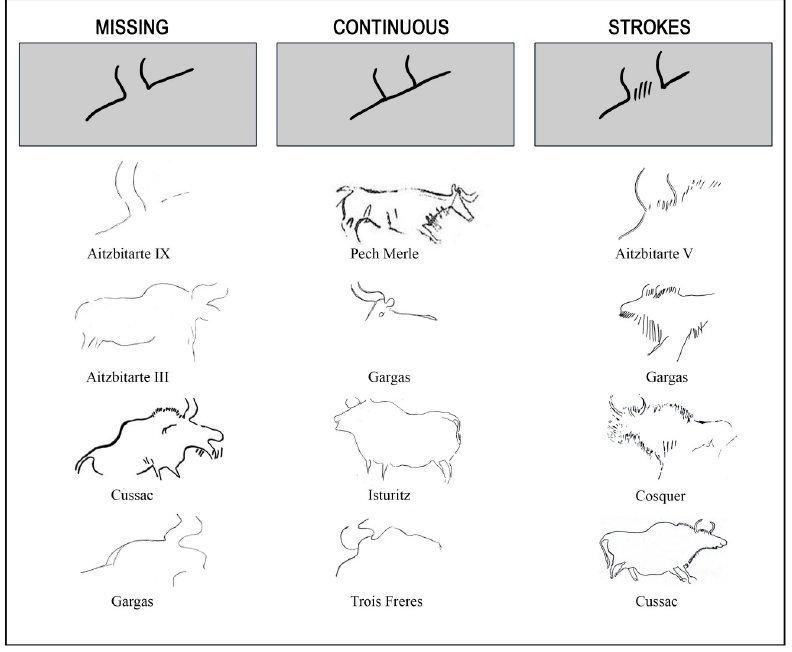
Fig 14. Different conventions to represent the space between the horns in bovids: Aitzbitarte V, IX, Isturitz [15], Cosquer [14], Gargas [12], Trois Fr è res [66], Cussac [13].